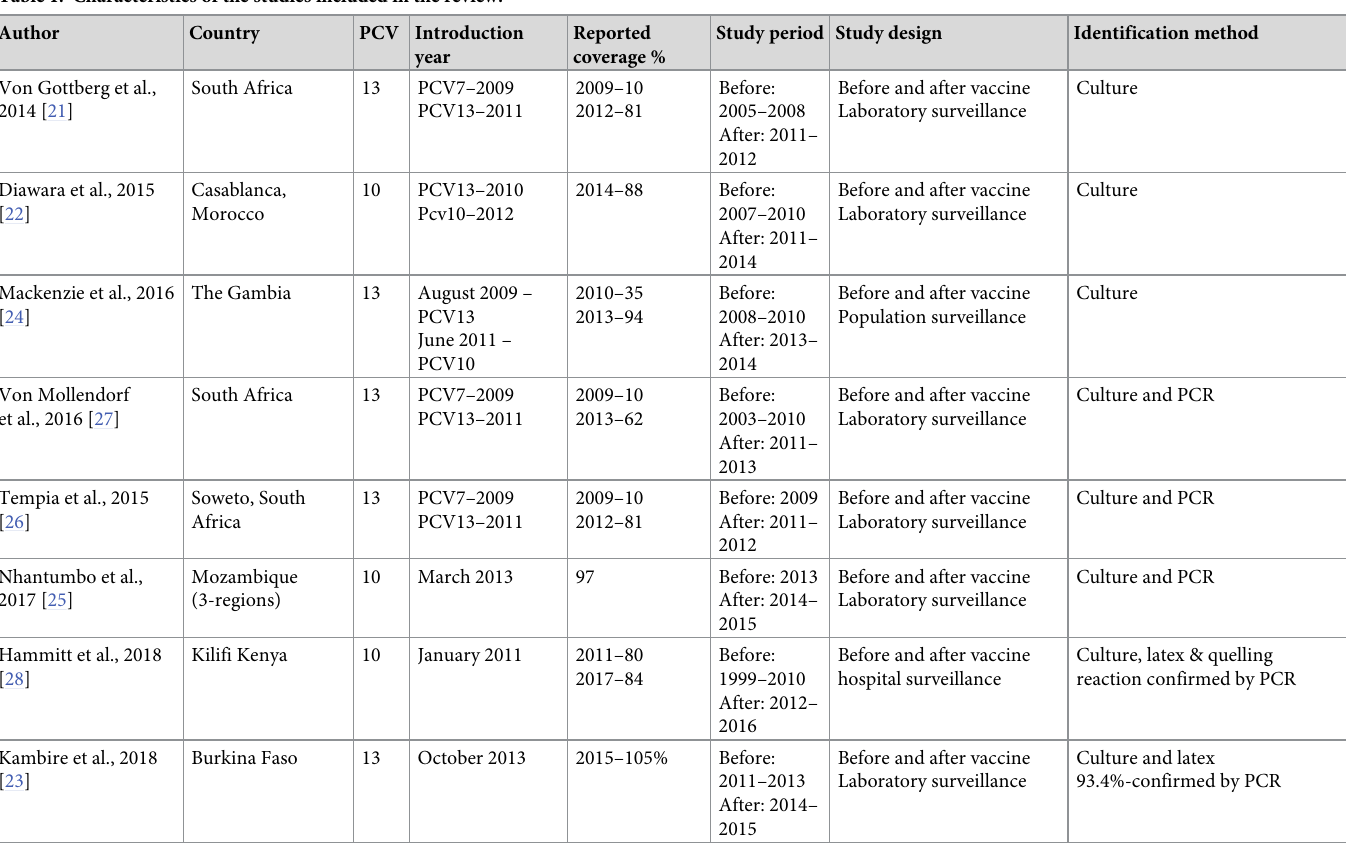
Table 1. Characteristics of the studies included in the